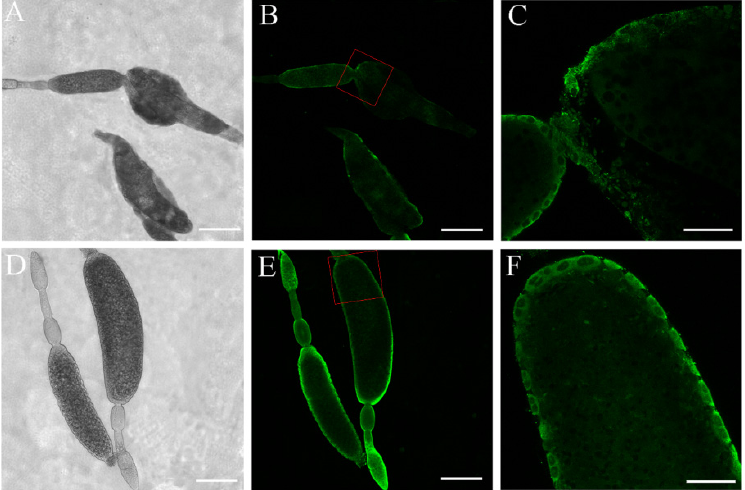
Figure 6. Ovarian follicle development after dsRNA treatment. ( A – B ) Follicles of females at 5 th day after ds NlPCE3 treatment. ( C ) Enlarged from B (red box). ( D – E ) Follicles of females at 5 th day after ds GFP treatment. ( F ) Enlarged from D (red box). Scale bar: 200 μ m ( A – B , D – E ); 50 μ m ( C , F ).